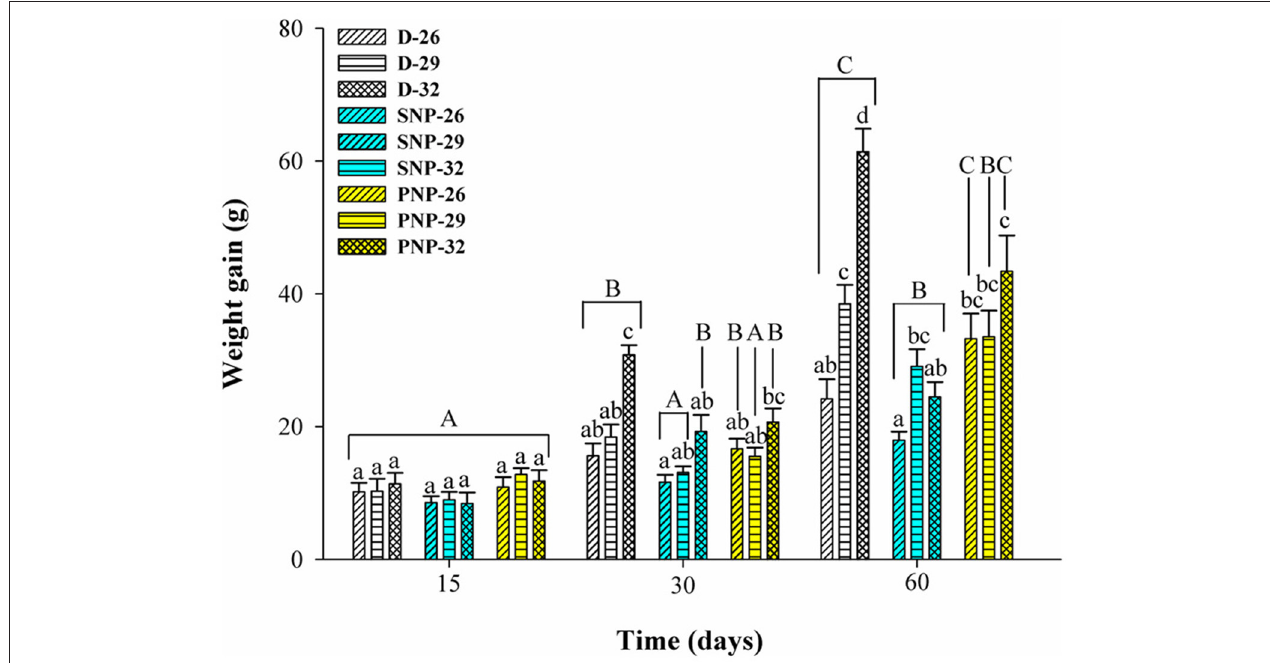
FIGURE 1 | Weight gain (g) of juveniles of Colossoma macropomum under controlled conditions of photoperiod and temperature. Data are mean ± SEM ( n = 3). The different capital letters indicate significant differences in the same treatments over the experimental period ( p < 0.05), while the lower-case letters indicate significant differences in the different treatments in the same experimental period ( p < 0.05).